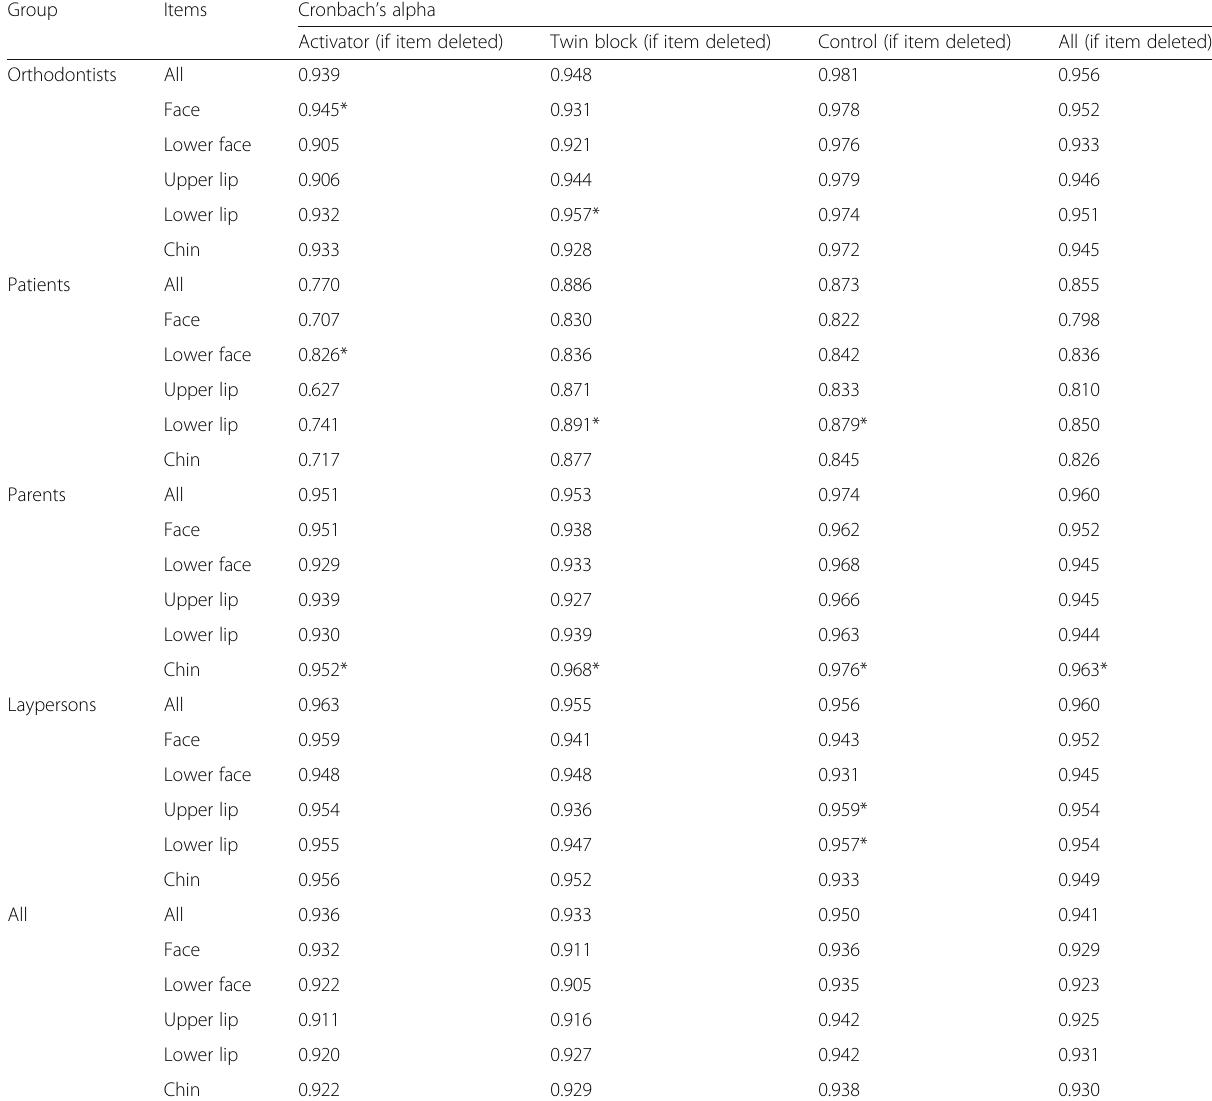
Table 3 Internal consistency of the answers of all rater groups for the three treatment groups, measured by Cronbach ’ s alpha, and influence of the deletion of each item by each subscale on Cronbach ’ s alpha values Group Cronbach ’ s alpha Twin block (if item deleted) Control (if item deleted) All (if item deleted)